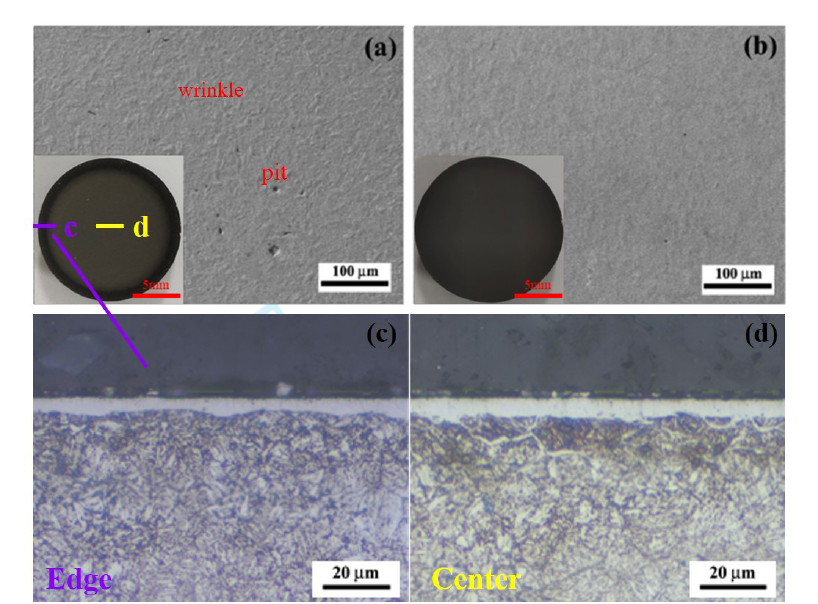
Figure 3. SEM surface topographies and optical photos of the (a)CPN and (b)HCPSN nitrided samples. Cross-sectional micrographs of edge (c) and central (d) area of the CPN nitrided sample.